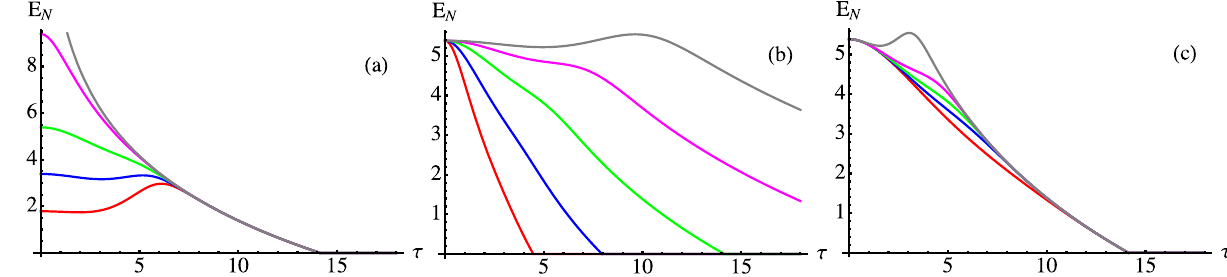
Figure 2. Entanglement negativity E N as a function of the dimensionless time τ for different values of the 0.01 and different values 1 , J 0 δ involved (dimensionless) parameters. In panel ( a ) we show results for (cid:31) = = 10, 2, 1, 0.5, 0.1 , corresponding to gray, magenta, green, blue and red curve, of r , from top to bottom r = 1 , and different values of the product J 0 δ , from top to 1 , r respectively. In panel ( b ) we show results for (cid:31) = = 3 , 10 5 / 2 , 10 2 , 10 3 / 2 , 10 1 [same colors as in panel ( a )]. In panel ( c ) we show results for 10 bottom J 0 δ − − − − − = 0.01 , r 1 , and different values of (cid:31) , from top to bottom (cid:31) 10, 2, 1, 0.5, 0.1 [same colors as in panel J 0 δ = = = ( a